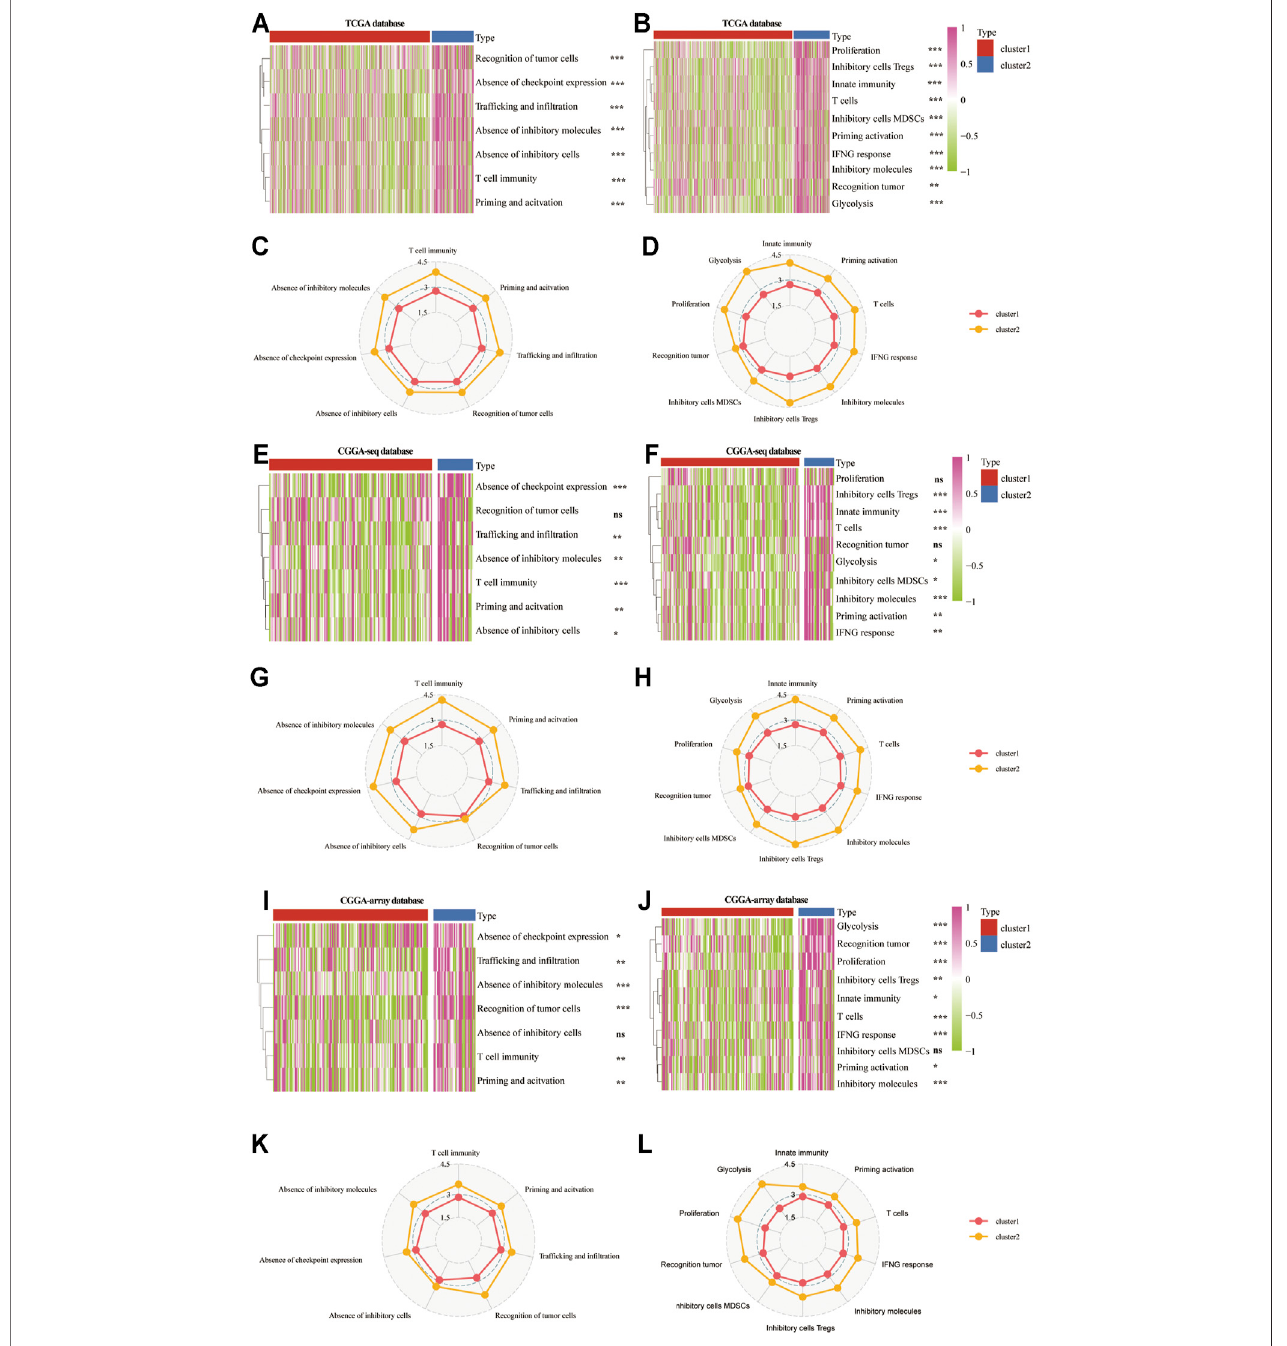
FIGURE5| The patient-speci fi clandscape ofthe LGGtumor microenvironment incluster1and cluster2from thetraining andvalidationcohorts. Heatmap shows the expression of immune landscapes in two clusters based on 2017 (left) and 2020 (right) immunogram algorithm from the TCGA (A , B) , CGGA-sequence (E , F) , and CGGA-array (I , J) databases. The radar chart shows the expression of the immune landscape in two clusters based on the 2017 (left) and 2020 (right) immunogram algorithm from the TCGA (C , D) , CGGA-sequence (G , H) , and CGGA-array (K , L) databases. * p < 0.05, ** p < 0.01, *** p < 0.001, NS, no signi fi cant differences.